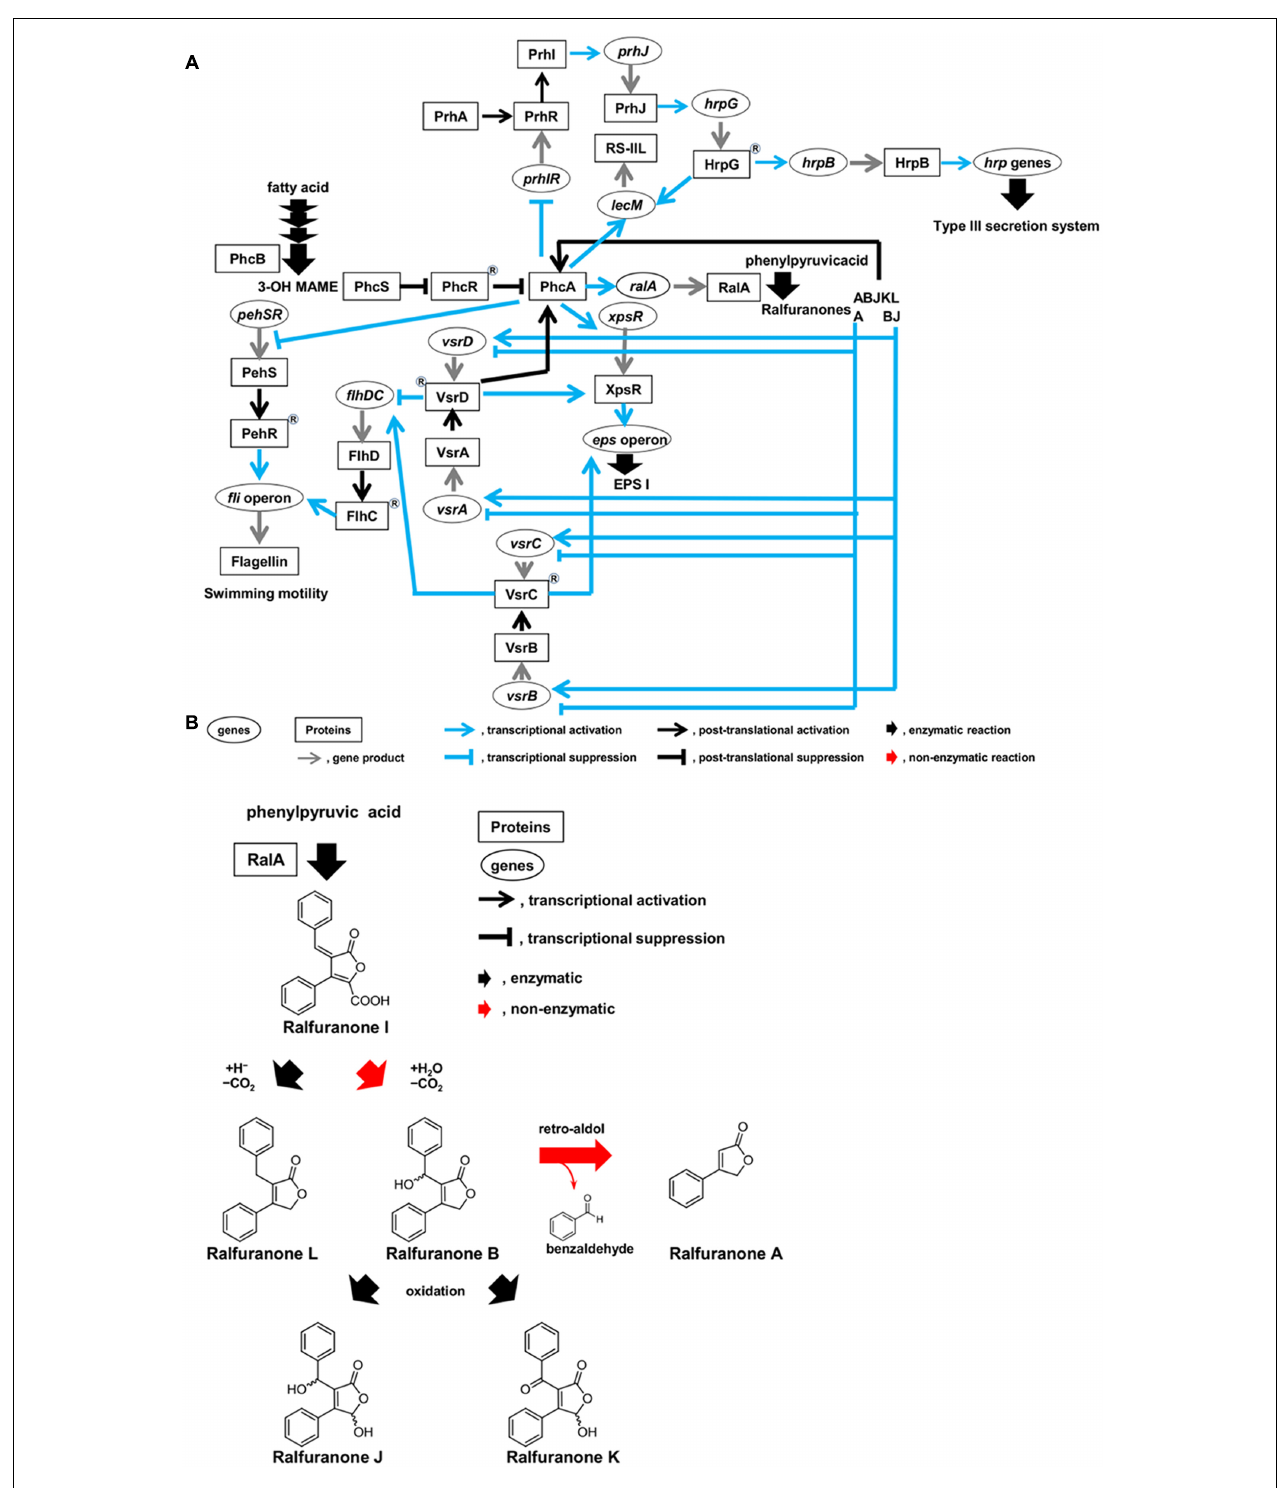
FIGURE 2 | Circuits of molecular traits involved in colonization of intercellular spaces (A) and schematic diagram of synthesis route of ralfuranones (B) in R. solanacearum strain OE1-1 during activation of quorum sensing. R. solanacearum strain OE1-1 produces methyl 3-hydroxymyristate (3-OH MAME) as a quorum sensing signal by PhcB, a putative methyltransferase, and ralfuranone I as a precursor of the other ralfuranones by RalA, a tridomain non-ribosomal peptide synthetase-like furanone synthetase. Ralfuranone I is non-enzymatically converted into ralfuranone B in the supernatant. The non-enzymatic elimination of benzaldehyde from ralfuranone B produces ralfuranone A. Ralfuranones J and K are the products of enzymatic oxidation of ralfuranone B. Ralfuranone L is enzymatically synthesized from ralfuranone I.